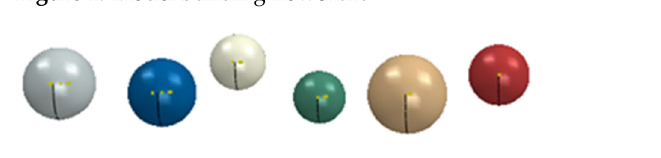
Figure 2. Diagram of random